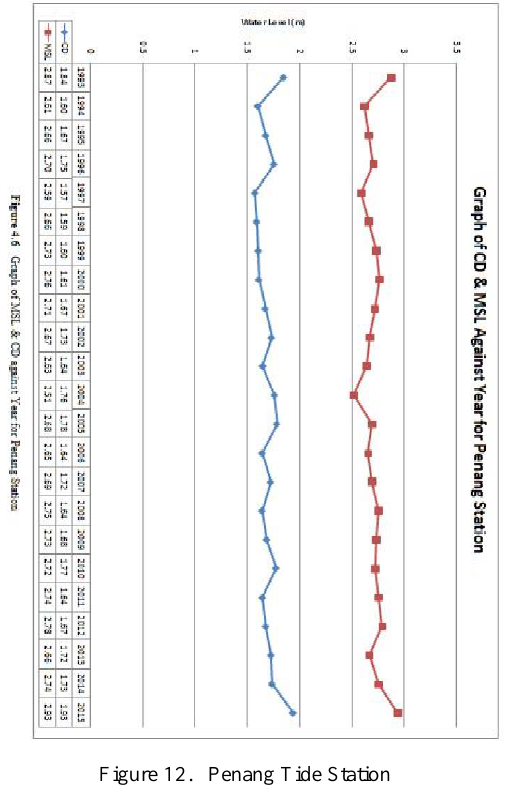
Figure 14. Kukup Tide Station Below are the lists of equation obtained from the graph of MSL and CD against Year by calculating the gradient of the graph as shown in Table 1.